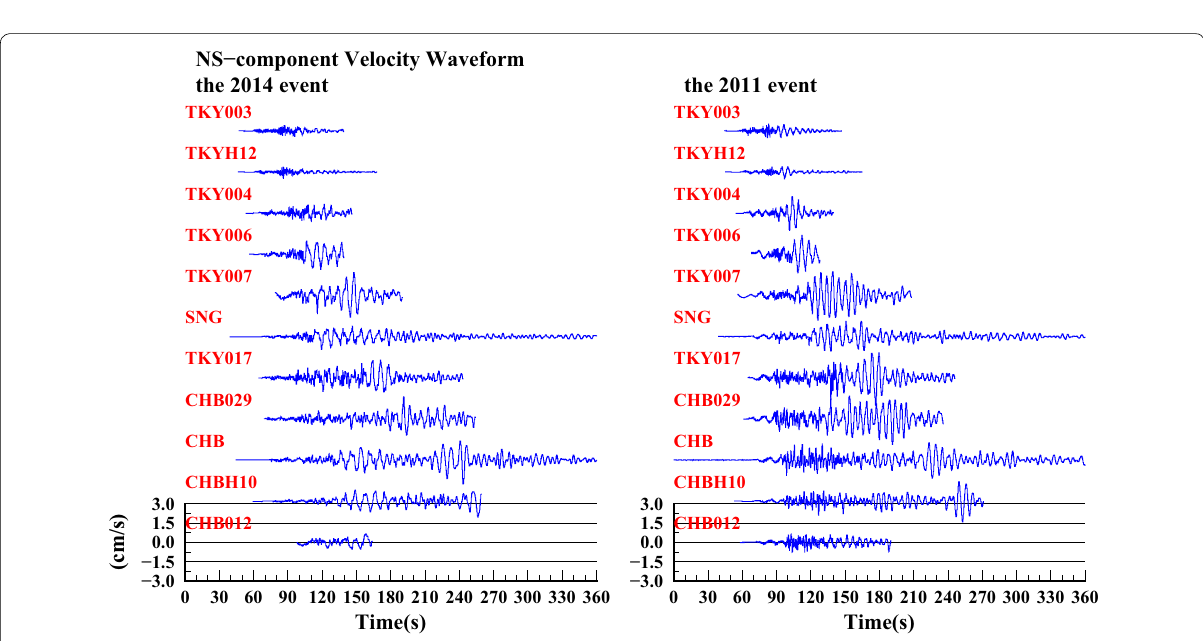
Fig. 5 Comparison of NS component velocity seismograms between the 2014 and 2011 events at stations on a west–east observation line in northern Tokyo Bay. Characters associated with each trace indicate the station code. The location of each station is shown in Fig.